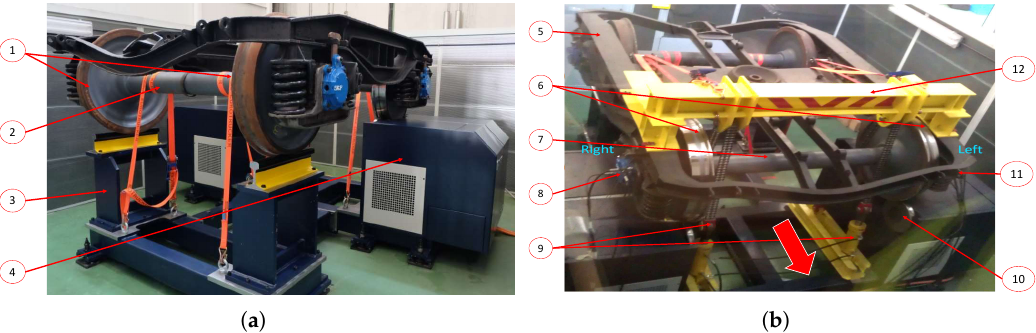
Figure 1. Components of the bed test. ( a ) Back view of the test bed. ( b ) Front view of the test bed.